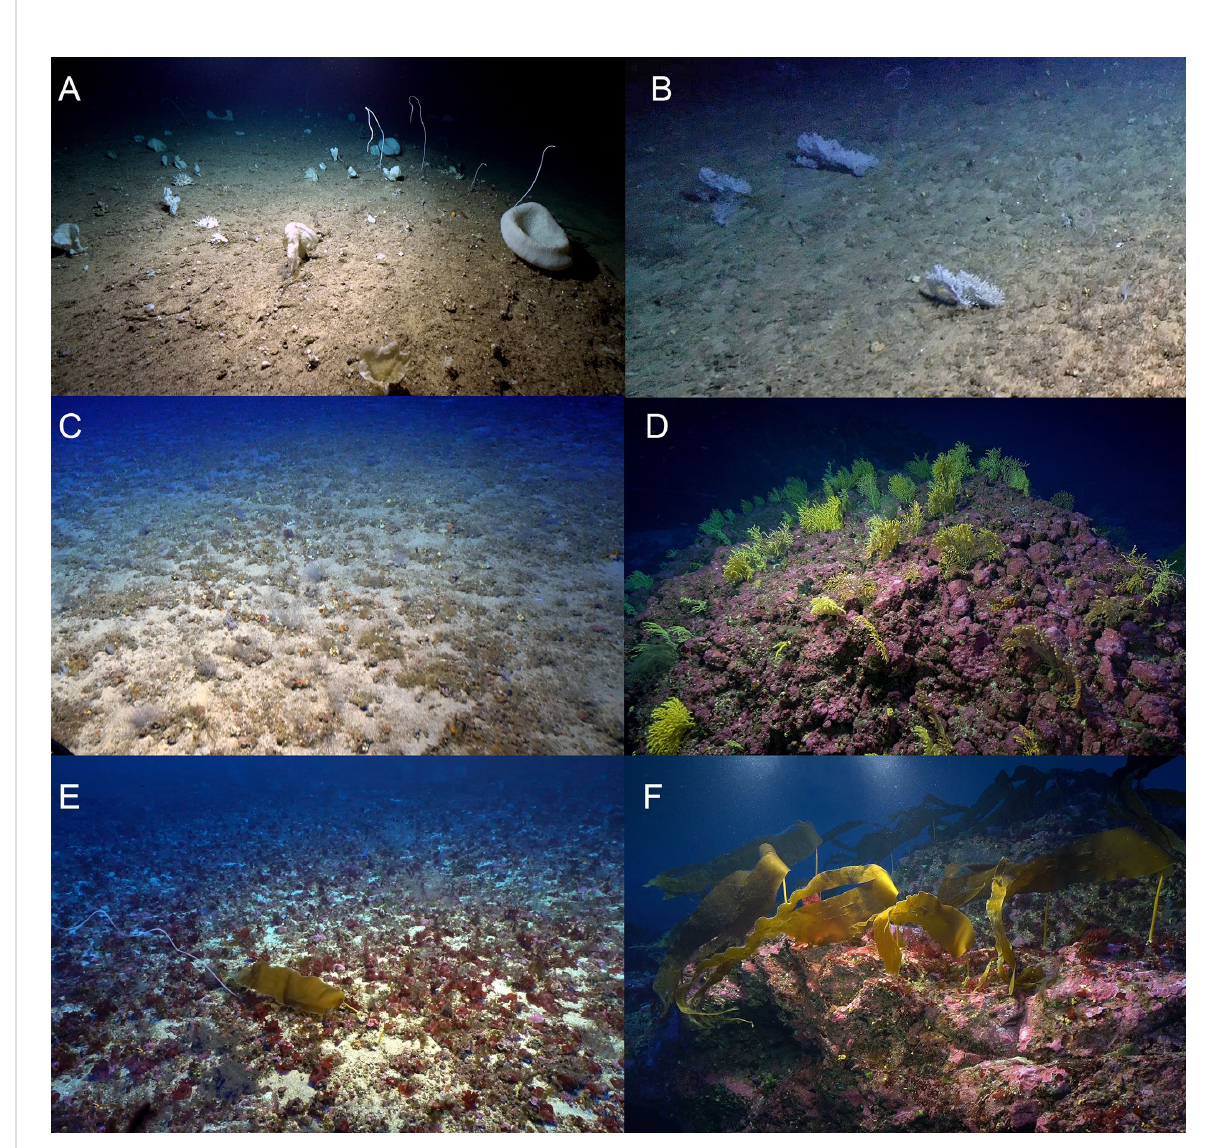
FIGURE 10 Examples of the six biotopes found at the Madeira-Desertas Ridge: aphotic (A,B) , ecotone (C) and mesophotic ecosystems (D – F) . (A) Mixed Viminella and sponge garden, here with Viminella fl agellum , Asconema setubalense , astrophorina Pachastrella monilifera , and various demosponges; (B) Eunicella garden; (C) Antipathes sp. garden on level sandy bottom; (D) Paramuricea garden; (E) Maërl bed with small (juvenile) Laminaria ochroleuca ; and (F) L. ochroleuca